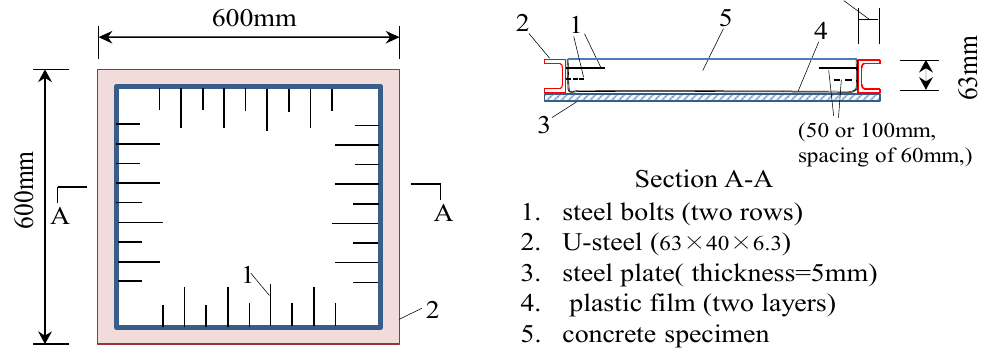
Figure 3. Crack test in the standard test method of fiber concrete in China [33].